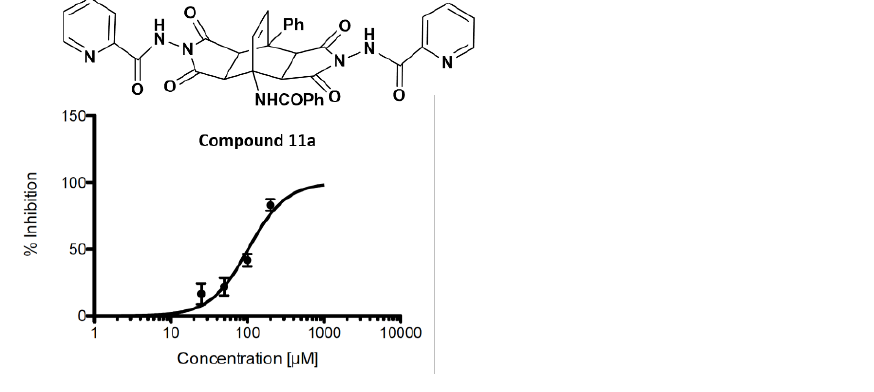
Figure 3. Determination of the IC 50 value of the SARS-CoV-2 3CL pro inhibition for the most active compound 11a .